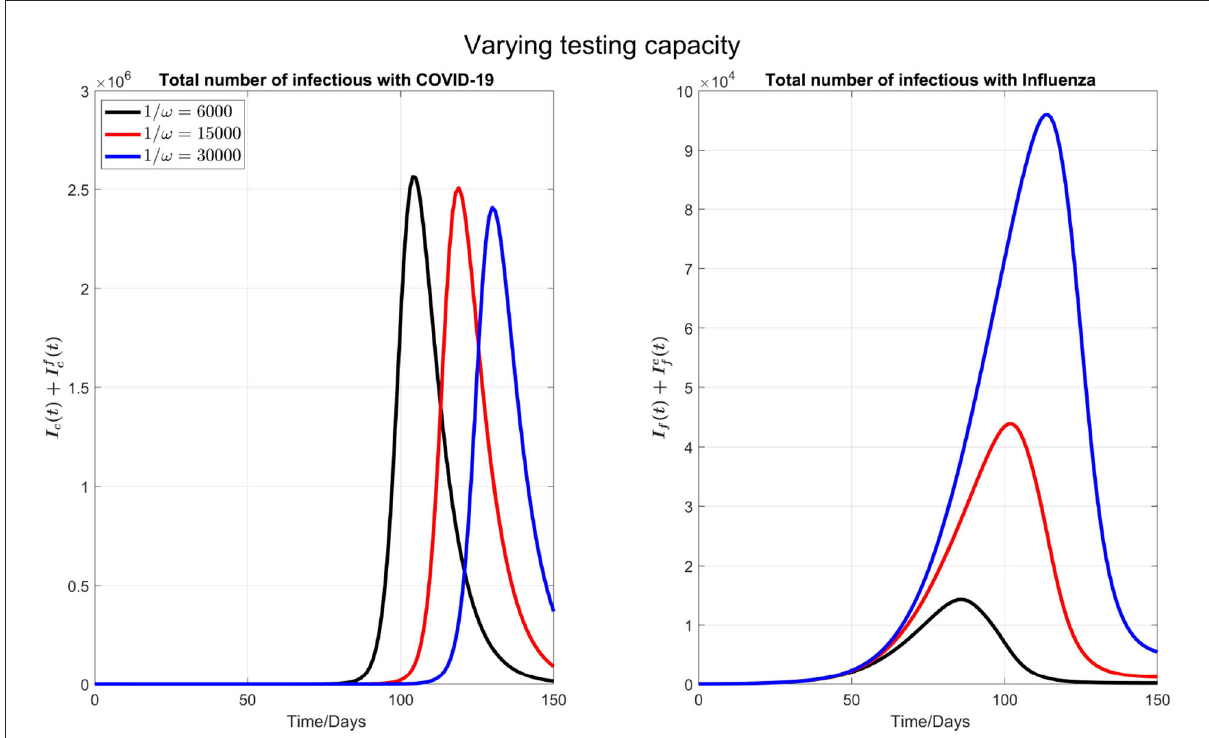
FIGURE2 The impact of varying the maximum testing capacity per day on COVID-19 and influenza disease prevalence. Left plot represents the total number of infections with COVID-19 ( I c ( t ) + I f c ( t )) and right plot shows the total number of infections with influenza ( I f ( t ) + I c f ( t